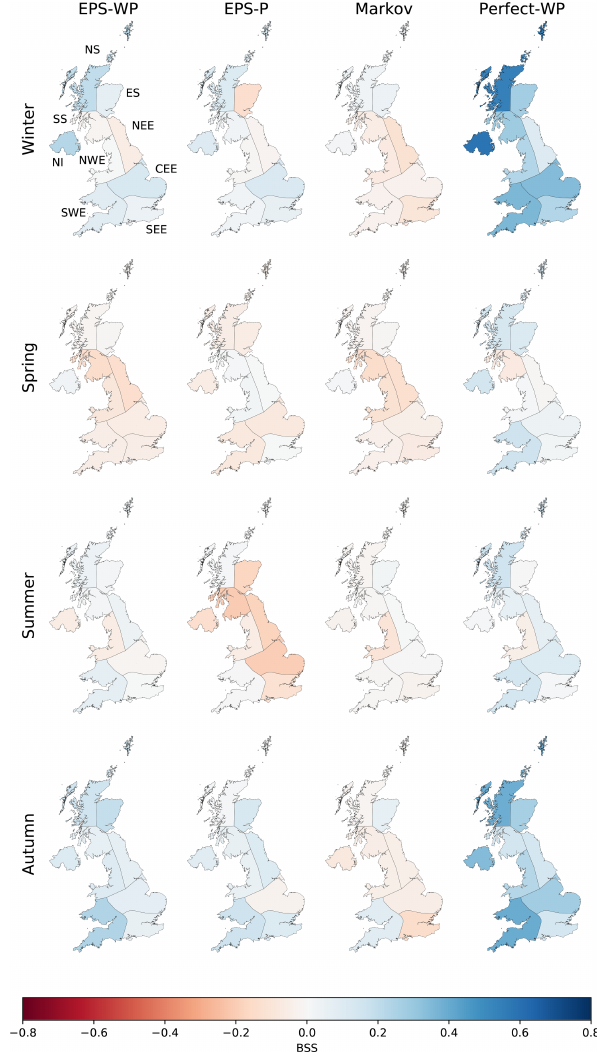
Figure 7. As Fig. 6 but for a 46d